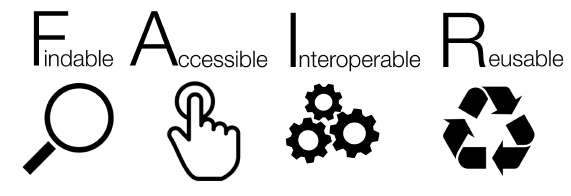
Figure 3. FAIR data principles: Findable, Accessible, Interopeable, Reusable. (Source: Wikipedia, © SangyaPundir